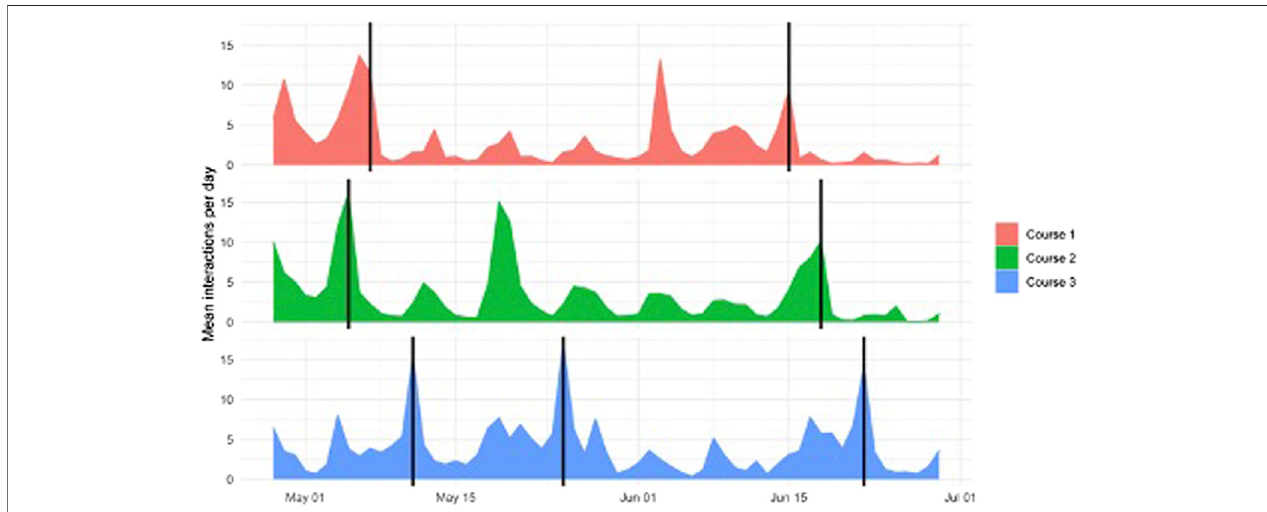
FIGURE 1 | The distribution of online engagement across the semester, for each course. The black vertical bars represent the assessment dates for each course.